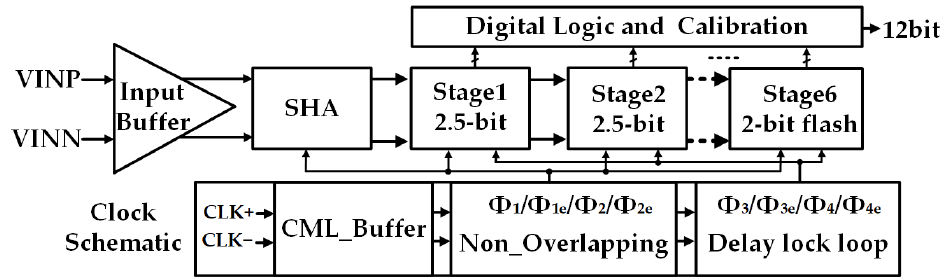
Figure 1. Block diagram of 1 GS/s 12-bit pipelined analog-to-digital converter (ADC). The proposed pre-quantization timing, including Ф 1 , Ф 1e , Ф 2 , Ф 2e , Ф 3 , Ф 3e , Ф 4 , and Ф 4e , is generated by a clock schematic. The clock schematic comprises a high-speed interface current mode logic (CML), a non-overlapping clock, and a DLL.